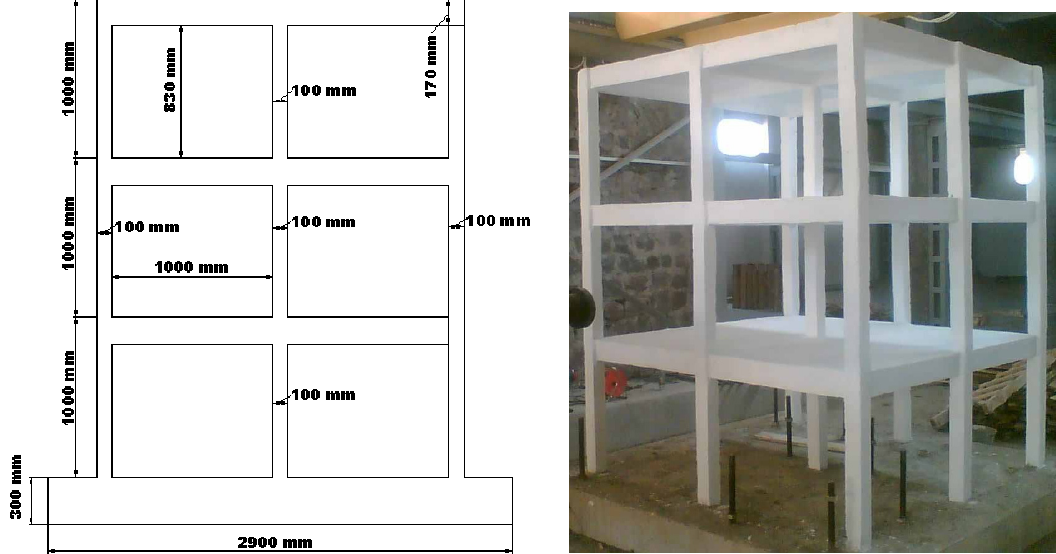
Figure 1. Structure and Dimensions of 3D Experimental Model (Altun, 2010) Fig. 1. Structure and dimensions of 3-D experimental model (Altun,